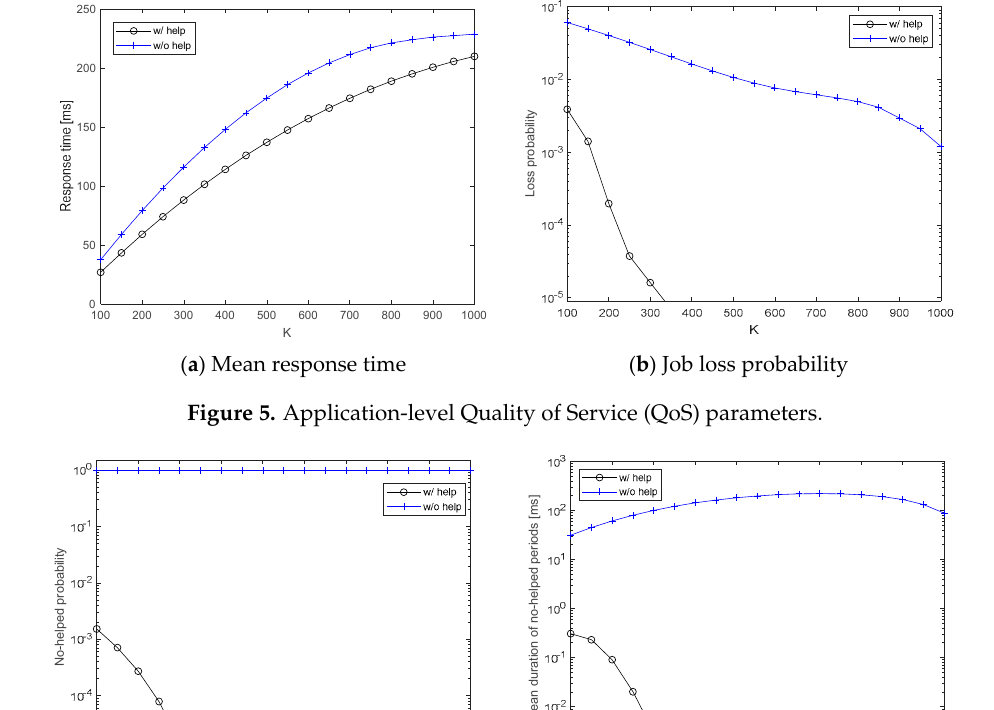
Figure 5. Application-level Quality of Service (QoS) parameters.